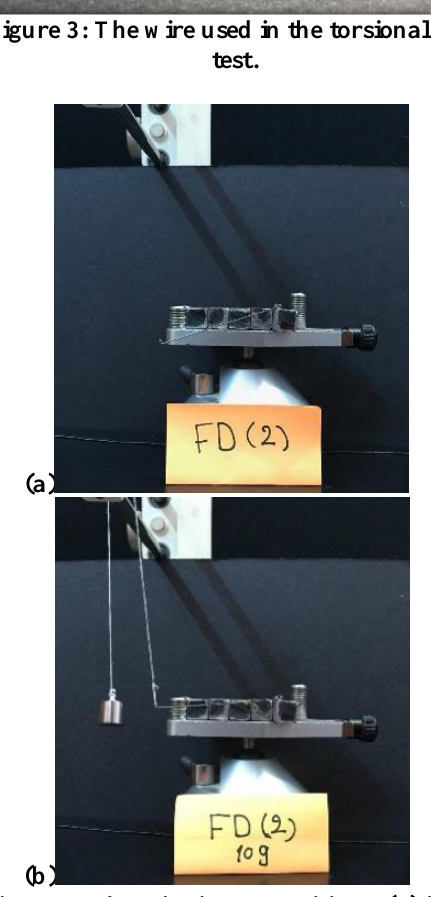
Figure 4: The wire in two positions: (a) in free fall and (b) after application of 10g weight.